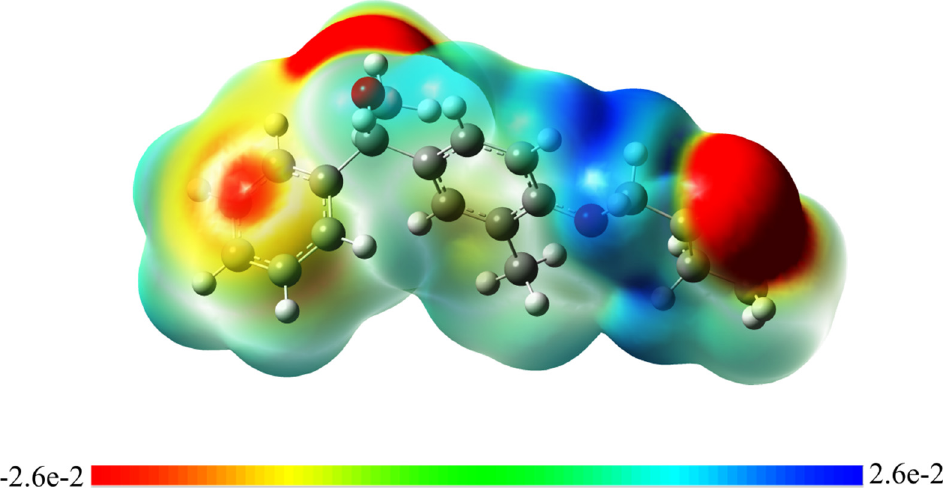
Figure 10. Molecular electrostatic map of the compound.